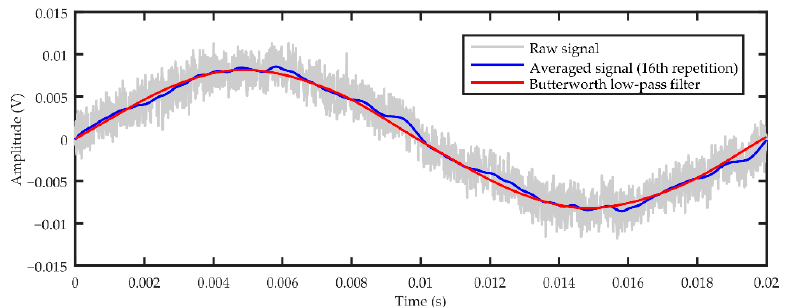
Figure 10. Example of two-stage filtering of a raw voltage signal using an averaging filter and a Butterworth low-pass filter.